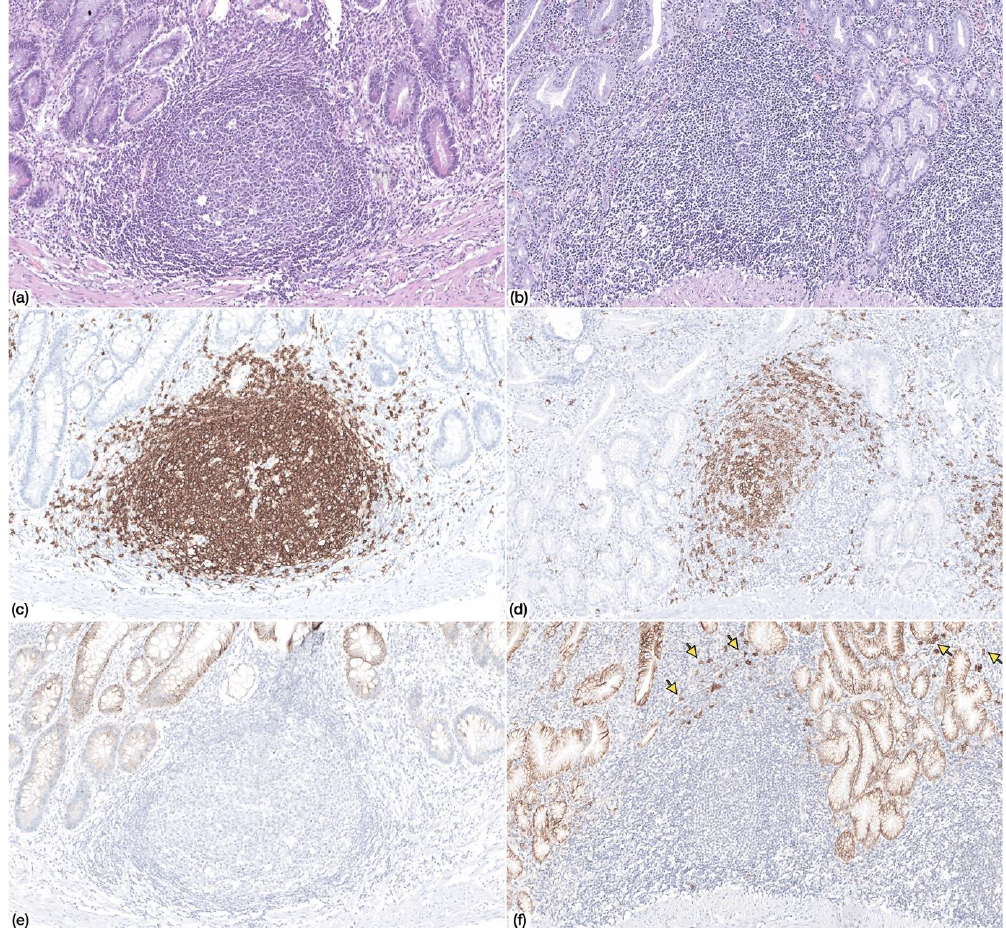
Figure 1. Non-neoplastic gastric mucosa displaying ( a ) lymphoid follicle with germinal center (Haematoxylin and Eosin, HE, 100×) ( c ) with CD20+ lymphocytes (IHC, 100×) and absence of CD138+ (Haematoxylin and Eosin, HE, 100 × ) ( c ) with CD20 + lymphocytes (IHC, 100 × ) and absence of CD138 + plasma cells ( e ) (IHC, 100×) — Patient 9. ( b ) Non-neoplastic gastric mucosa displaying a lymphoid plasma cells ( e ) (IHC, 100 × )—Patient 9. ( b ) Non-neoplastic gastric mucosa displaying a lymphoid follicle without germinal center (HE, 100×) with ( d ) CD20+ lymphocytes and ( f ) scattered CD138+ follicle without germinal center (HE, 100 × ) with ( d ) CD20 + lymphocytes and ( f ) scattered CD138 + plasma cells at the periphery (arrows) — Patient 4. plasma cells at the periphery (arrows)—Patient